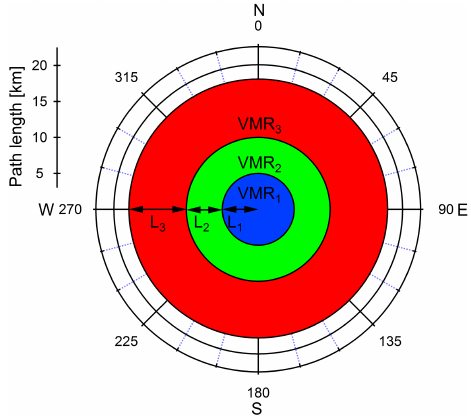
Figure 5. Conceptual sketch of the onion-peeling approach. See text for